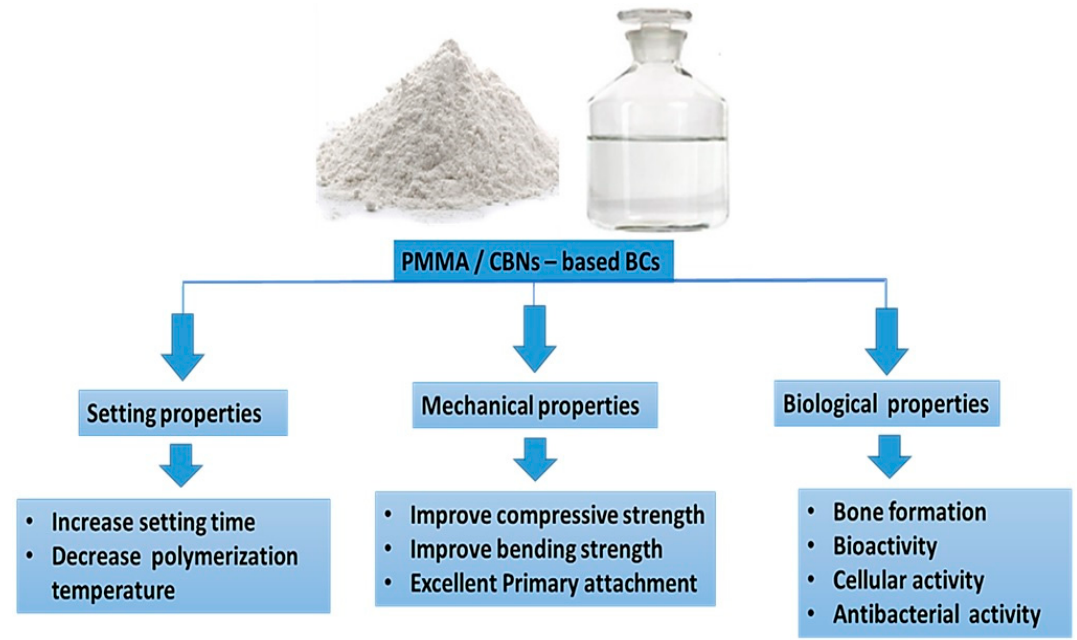
Figure 8. The future trend of PMMA/CBNs-based BCs.